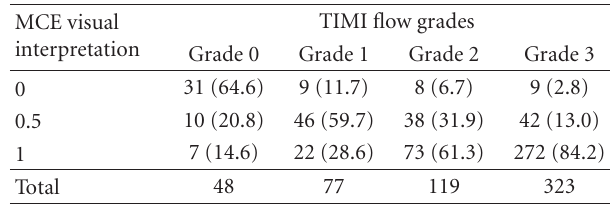
Figure 1: Region of interest (ROI, 5mm × 5mm) was placed in the middle of the six myocardial segments, and the ROI was tracked manually to assure its center position in each segment. The reperfusion curves of acoustic contrast intensity versus time were constructed automatically with QLab software. The specific values of signal intensity peak (A), the slope of slope of curve ( β ), and perfusion volume ( A × β ) were acquired. Table 3: MCE visual interpretation among at stress TIMI flow Table 2: MCE visual interpretation at rest among TIMI flow grades grades before PCI n before PCI n (%).